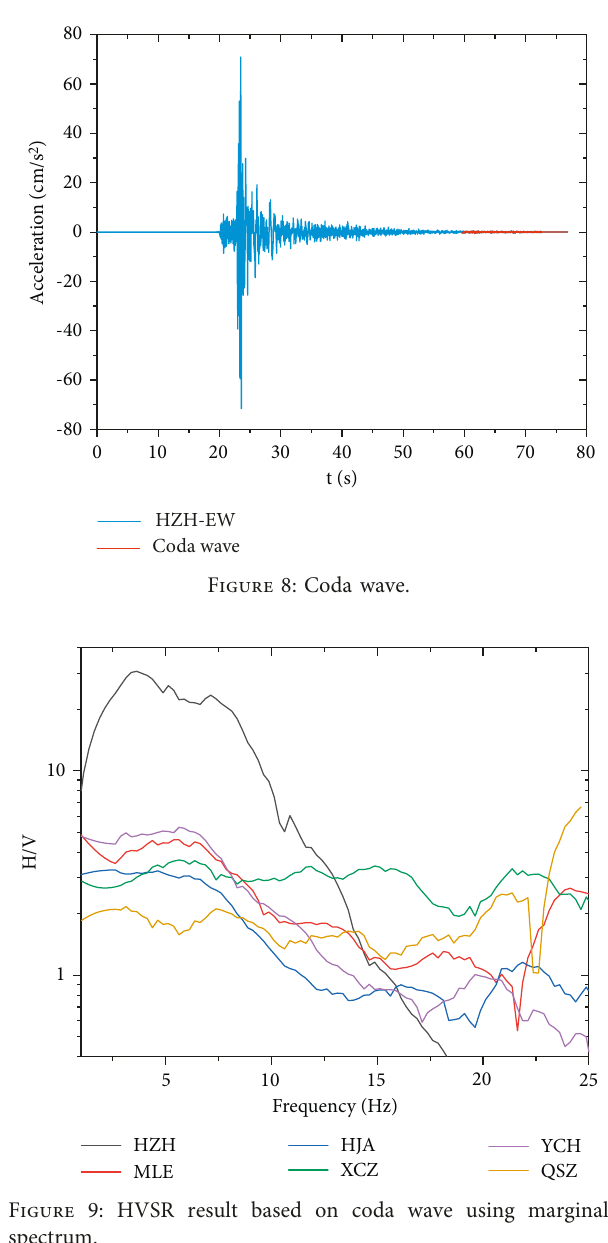
Figure 9: HVSR result based on coda wave using marginal